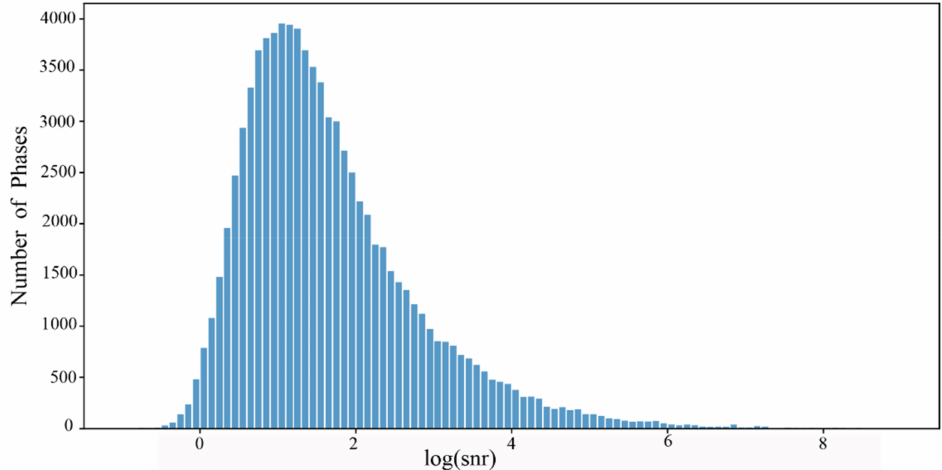
Figure 2. The rms SNR of seismic signals. The window of the signal is 10s after the arrival time, and the window of noise is 5 s before the arrival